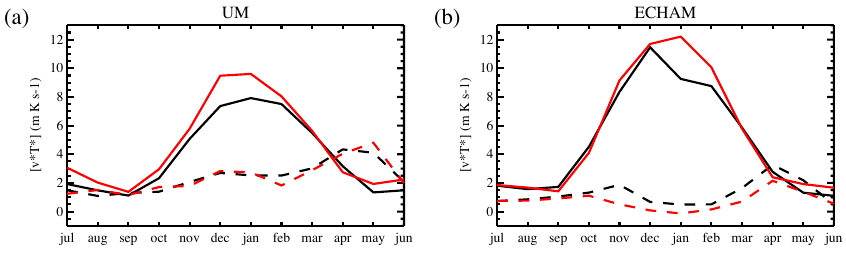
Fig. 3. Monthly climatological heat flux [ v ∗ T ∗ ] at 100hPa (area-weighted average between 40 ◦ and 80 ◦ , in mKs − 1 ) for the control run (black lines) and for the doubled CO 2 run (red lines), for the NH (solid) and minus SH (dashed), for (a) the UM model and (b) the ECHAM model, as a function of time (months). Months noted on the horizontal axis are for the NH, and the SH values are shifted by 6 months compared to this axis.